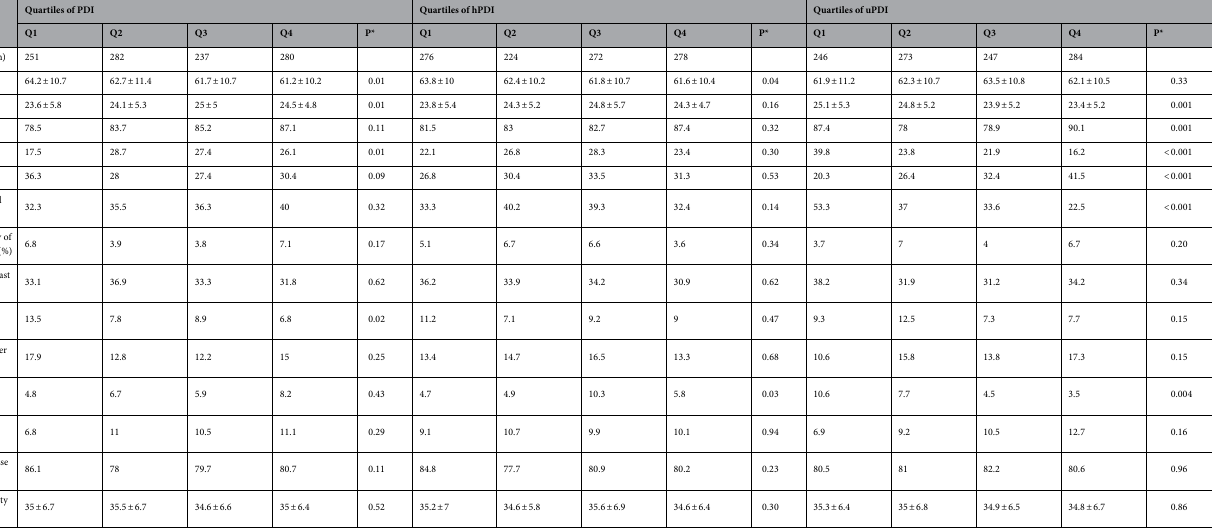
Table 2. Demographic characteristics of study participants across quartiles of PDI, hPDI, and uPDI scores. All values are mean ± SD or percent. BMI body mass index, MET metabolic equivalents, SES social